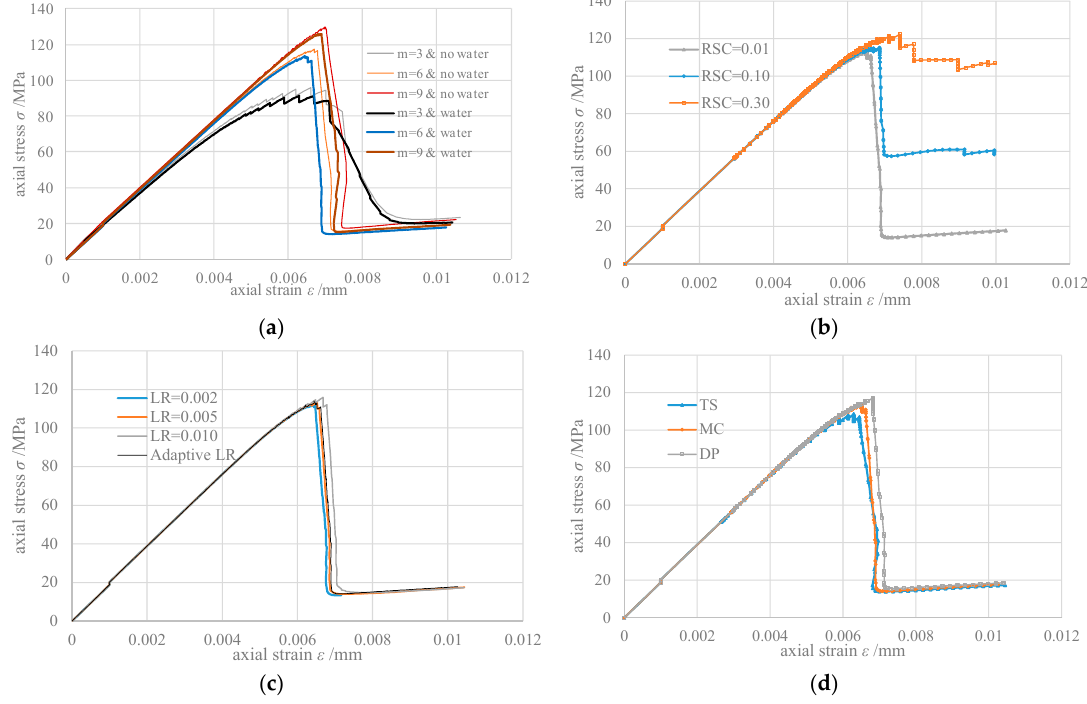
Figure 7. Stress-strain curves under different variables: ( a ) Different heterogeneity degrees; ( b ) Different ratio of residual strength to initial strength (RSC) values; ( c ) Different displacement per unit time (LR) values; ( d ) Different strength criteria.